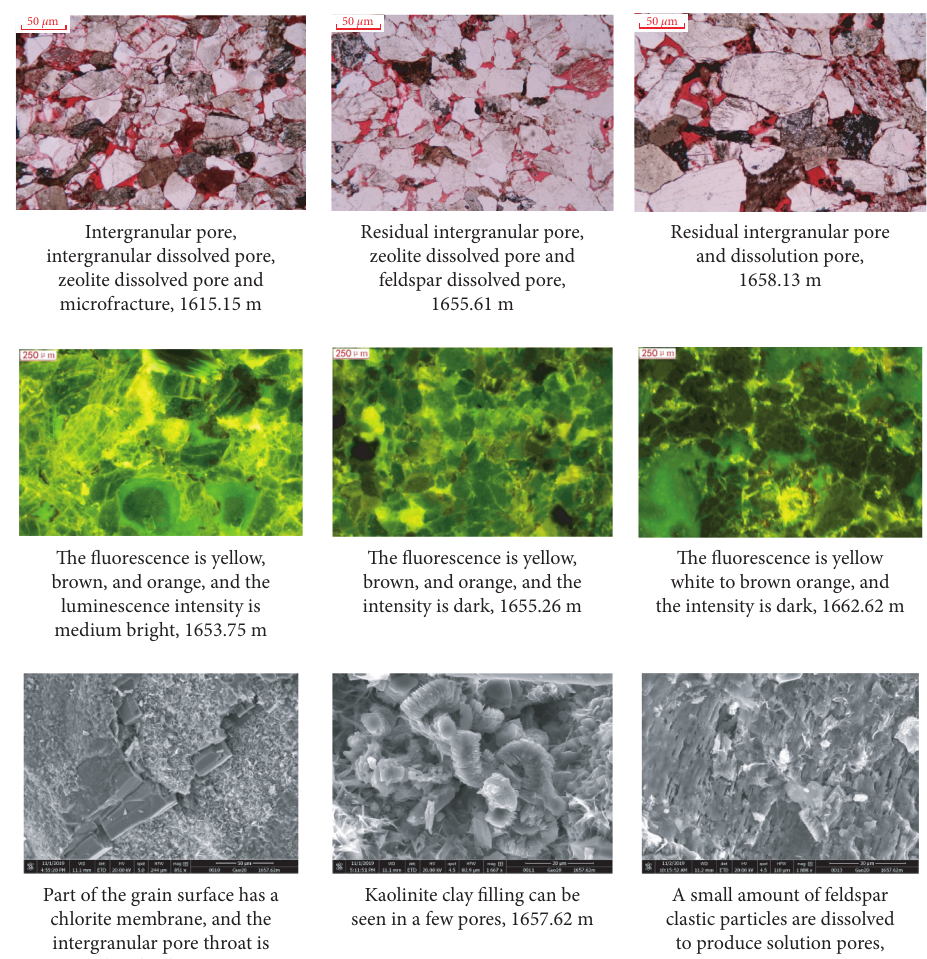
Figure 6: Thin section, fluorescence, and SEM images of samples from well